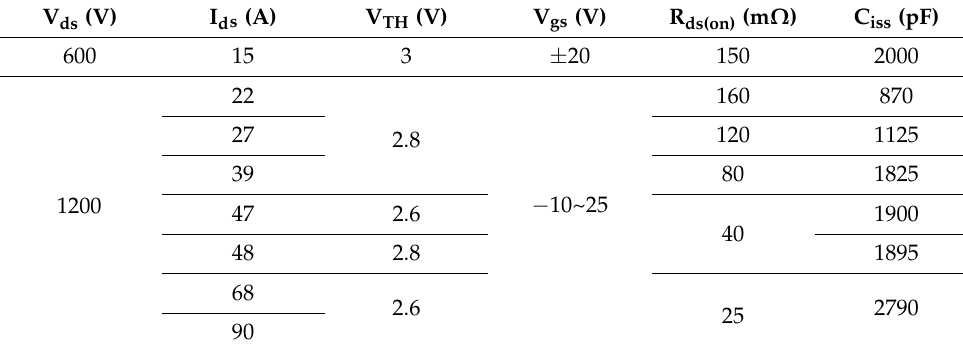
Table 5. Commercial 600~1200 V SiC MOSFETs by